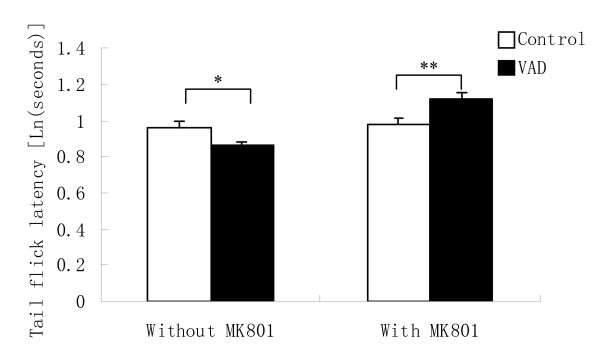
Effects of vitamin A depletion (VAD) on tail flick latency without and with MK-801 injection. Each column represents mean value ± SEM of mice tail flick latency [ln (seconds)]. Vitamin A depletion induced significantly shorter tail flick latency compared to the control mice (*P < 0.05). After MK-801 administration, vitamin A depletion mice displayed significantly longer tail flick latency than the controls (**P < 0.01).